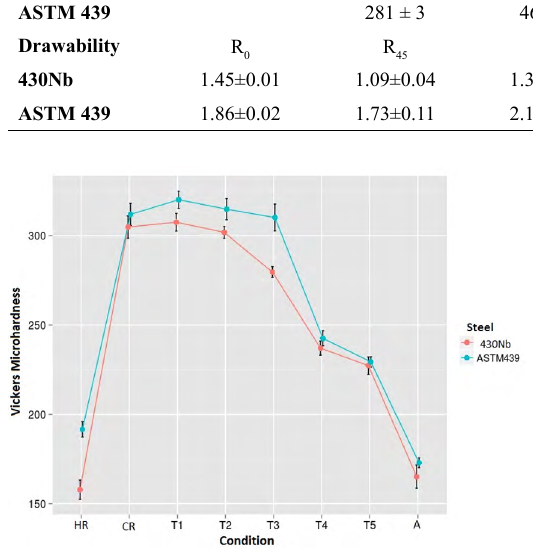
Figure 9. Mean values of Vickers microhardness for steels 430Nb and ASTM 439 in different conditions.